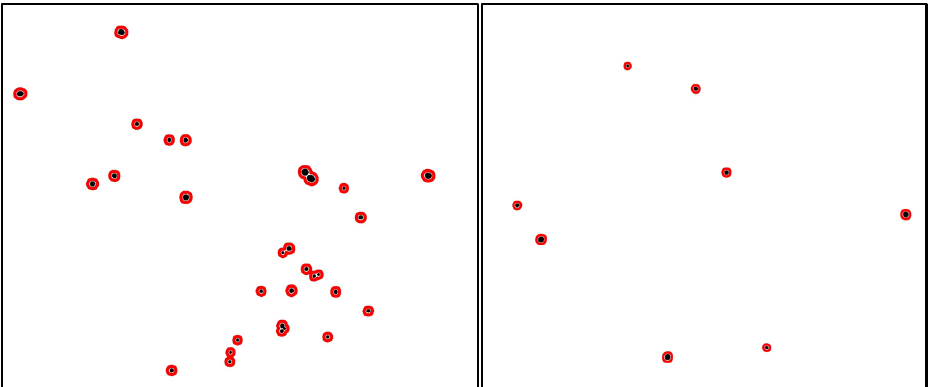
Figure 13. Samples of predicted whole-image segmentation maps reconstructed from patches ac- quired using the ensemble-based